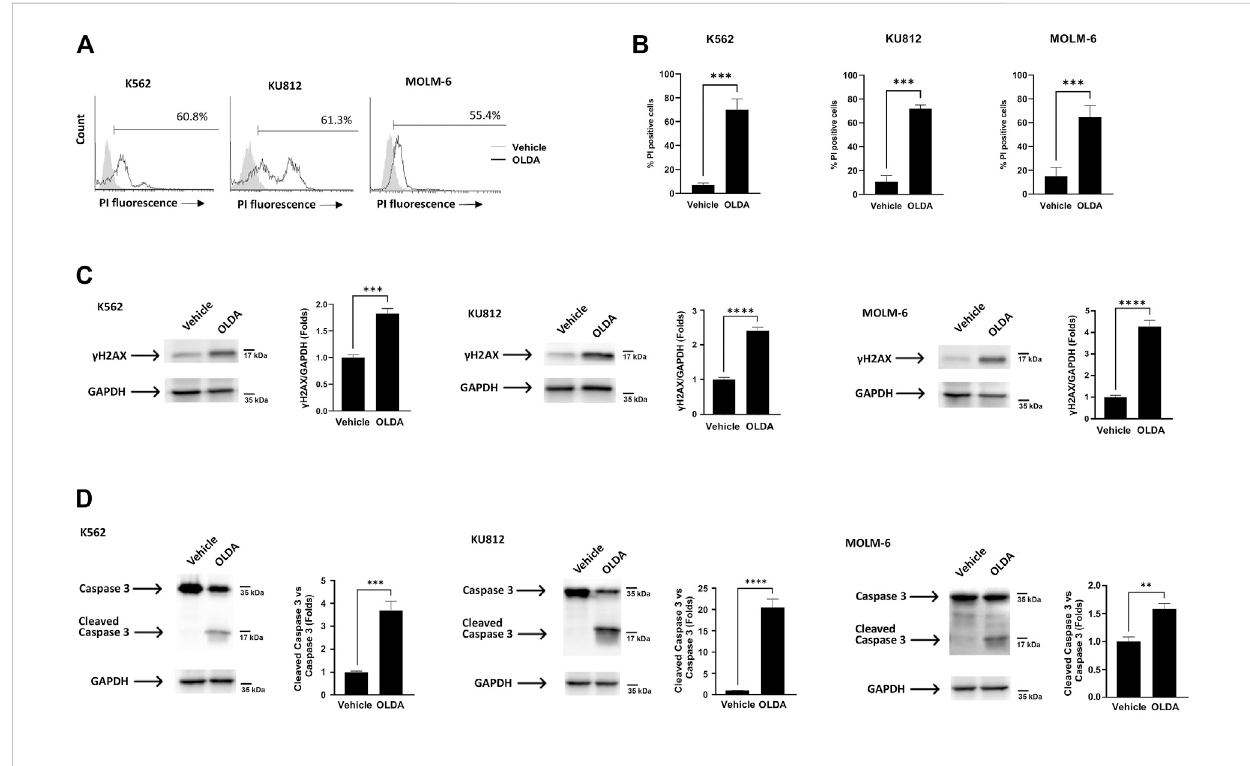
TriggeringofTRPV1promotesapoptoticcelldeathofCMLcells. (A) PIstainingofCMLcellstreatedwithOLDAattheIC 50 doseorwiththevehiclefor 24 h. Data are representative of three experiments. Percentage indicates PI-positive cells. (B) Percentage of PI-positive cells in CML cells treated as previously described. Data are the mean ± SD of three separate experiments. *** p < 0.001. (C, D) Western blot analysis of γ H2AX (C) and caspase-3 cleavage (D) inCMLcellstreatedfor24 hwithOLDAattheIC 50